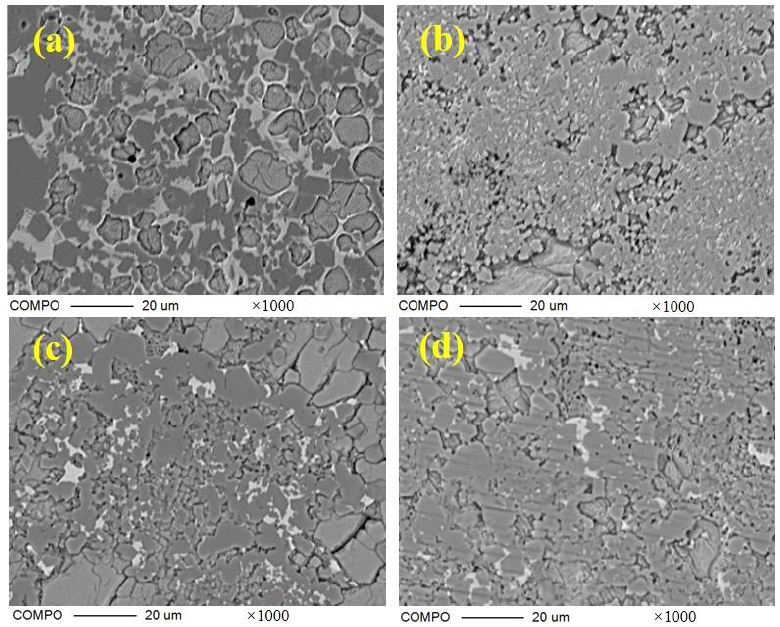
Figure 5. BSE micrograph of polished section of samples with 1000 times magnification; ( a ) S00; ( b ) S50; ( c ) S80; ( d ) S100.